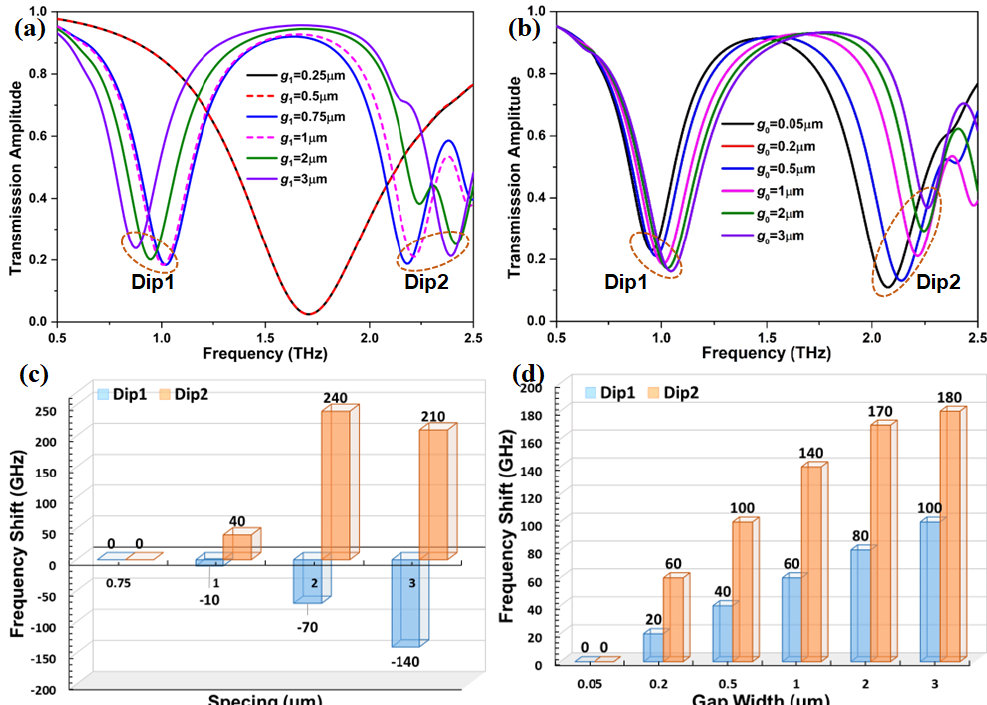
Figure 3. Transmission spectrum of the graphene metasurface as a function of ( a ) the spacing between the circular graphene ring and the H-shaped microstructure, and ( b ) the gap width of the H-shaped microstructure. ( c , d ) The frequency shift versus different spacing and gap widths in the proposed